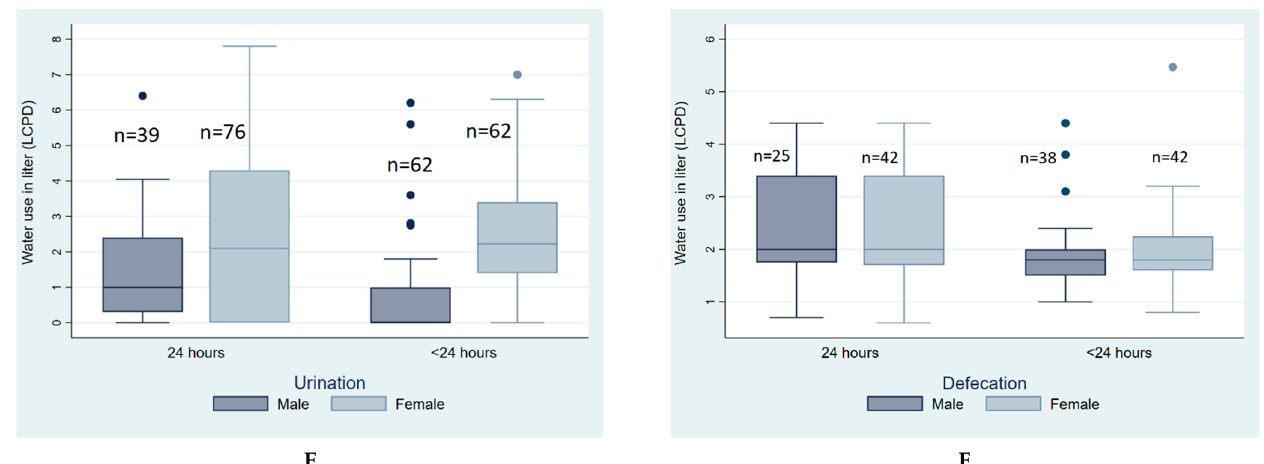
Figure 1. Quantity of water used for personal hygiene LCPD based on water availability among low-income urban residents of Arichpur, Dhaka, from May 2015 to March 2016. ( A ). Total water use, ( B ). Water use for bathing, ( C ). Water use for handwash with soap, ( D ). Water use for face wash with soap, ( E ). Water use for urination, ( F ). Water use for defecation.